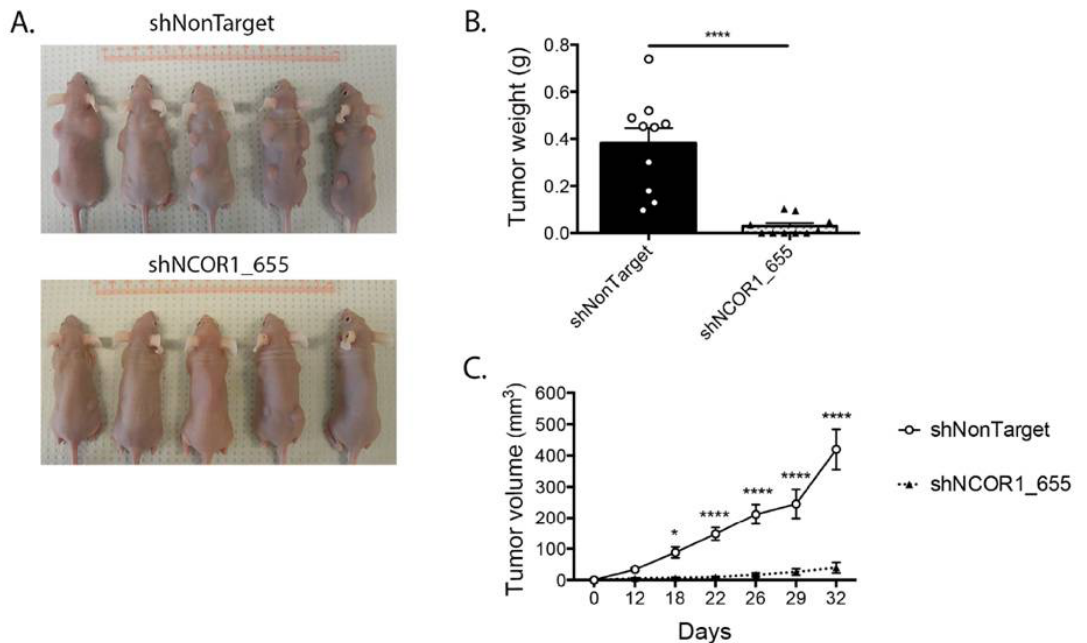
Figure 6. NCOR1 downregulation leads to a reduction of HT-29 tumorigenic cell growth in vivo. Xenografts were performed with female nu/nu mice aged between 4 to 6 weeks. ( A ) Representative photographs of mice 32 days after injection of HT-29 shNonTarget or shNCOR1_655 cells; 7 d after lentiviral infections, populations of viable cells were injected subcutaneously into the shoulder blades and hips of 5 animals per condition (1 × 10 6 adhered cells per site resuspended in 0.1 mL DMEM, with four independent sites per mouse). ( B ) Tumor growth curves were established by measuring shoulder blade tumors lengthwise and widthwise using the formula (d2X D)/2 to calculate tumor volume. Two-way ANOVA tests and a multiple comparison test by Bonferroni’s method were used to measure the significance of the results (* p < 0.05; **** p < 0.0001). ( C ) Graph representing the mean weight of shoulder blade tumors at the time of sacrifice ( n = 2 (2 × 5 mice per condition); means ± SEM). Student’s t -tests were used to measure the significance of the results (**** p < 0.0001).